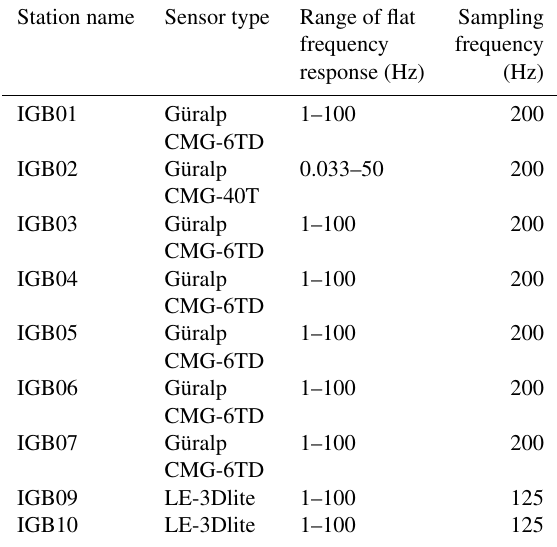
Figure 3. Flow depth and geophone impulses of Illgraben debris- flow event on 19 July 2011 (recorded near check dam 29).